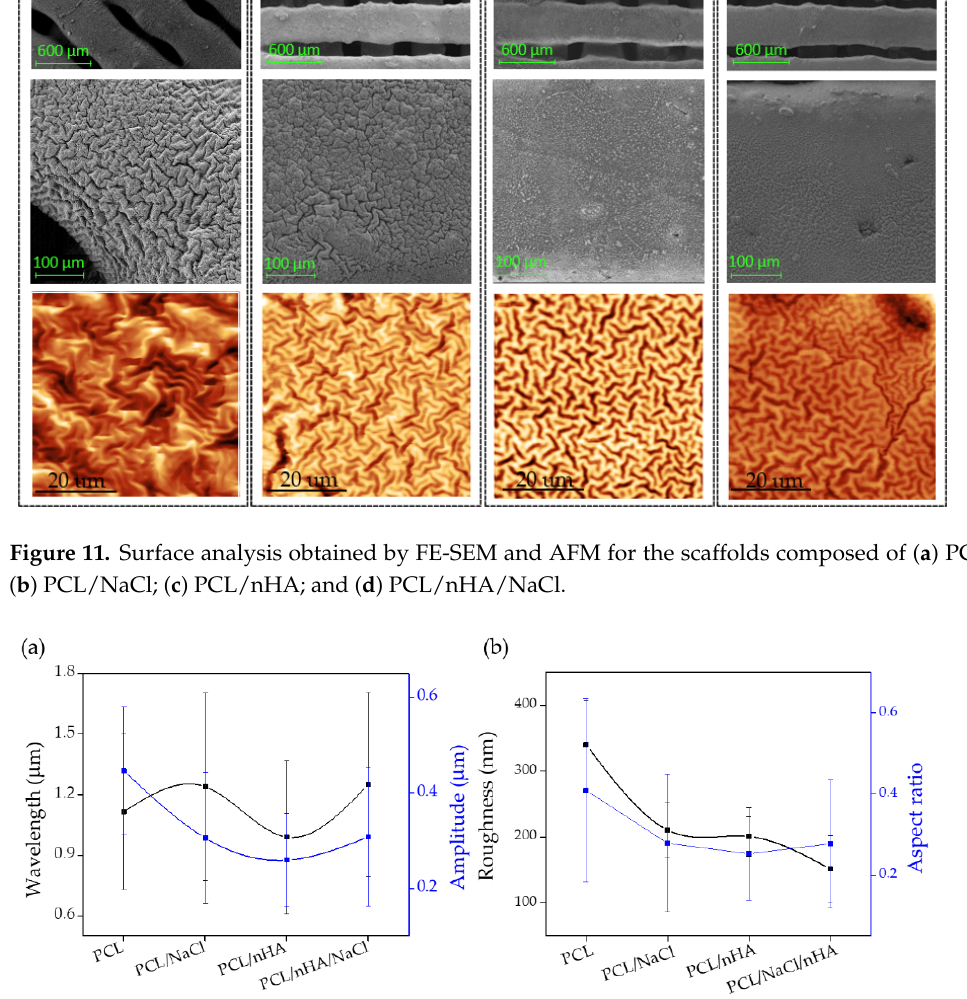
Figure 13. Cell viability studies obtained from AlamarBlue analysis for the samples PCL, PCL + Hydrogel, PCL/NaCl + Hydrogel, and PCL/nHA/NaCl + Hydrogel, for 1, 3, and 7 days incubation.